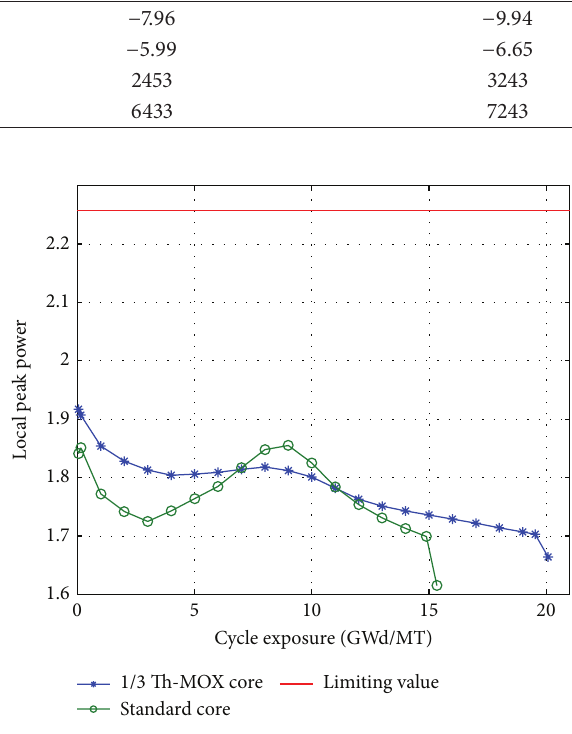
Figure 8: The local peak power as function of burnup for the standard and 1/3 Th-MOX